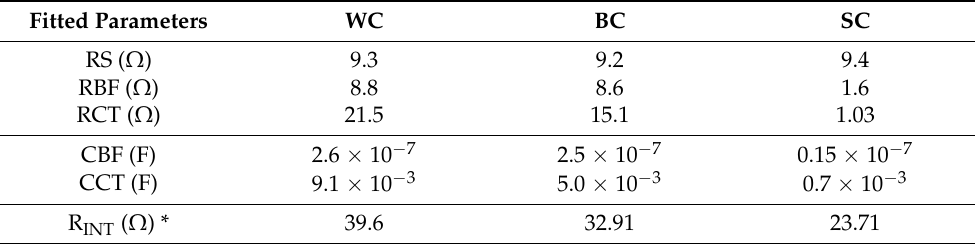
Table 4. Fitting parameters from EIS measurements for the leachate-fed MFC with the three different electrode cases examined. Fitted